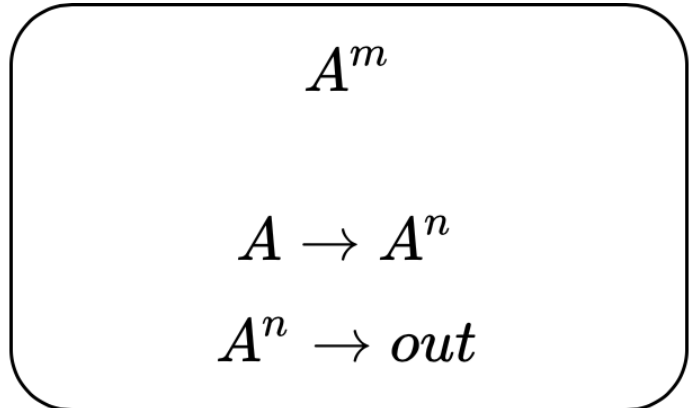
Figure 8. Membrane system with a Skin membrane, two evolution rules, and a multiset of objects. In every evolution step, the multiset of objects either expands or outputs an increased number of